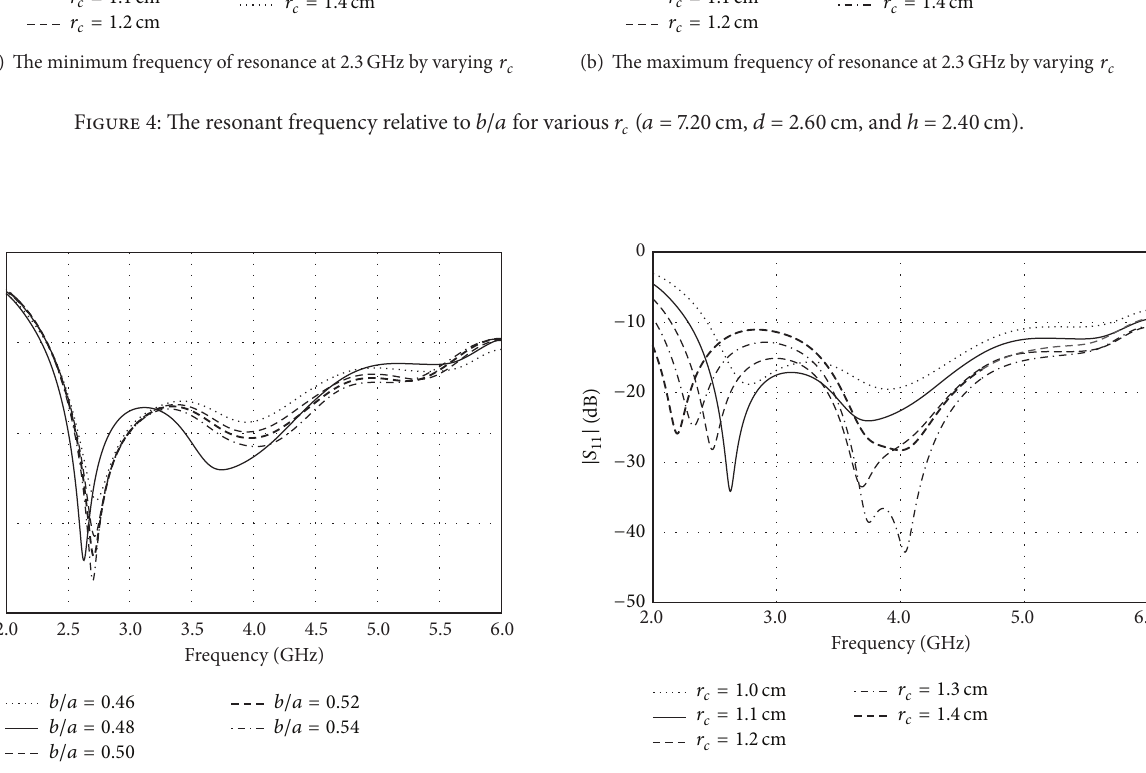
Figure 5: |𝑆 11 | versus frequency as a function of 𝑏/𝑎 ( 𝑎 = 7.20 cm, 𝑑 = 2.60 cm, ℎ = 2.40 cm, and 𝑟 𝑐 = 1.10cm).